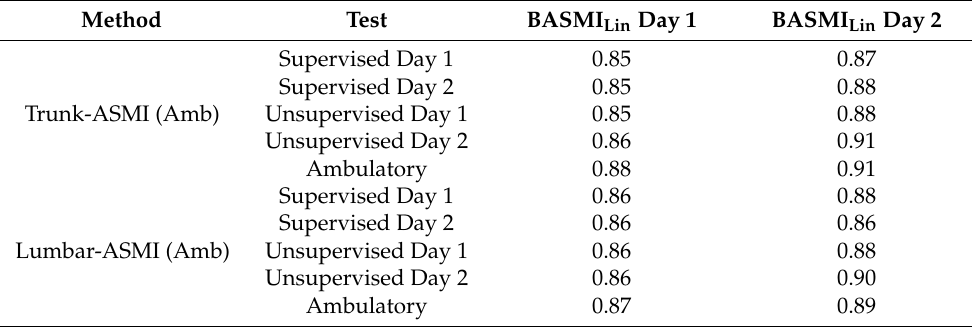
Table 7. Pearson correlations between BASMI Lin and IMU-ASMI (Amb) scores under laboratory and ambulatory